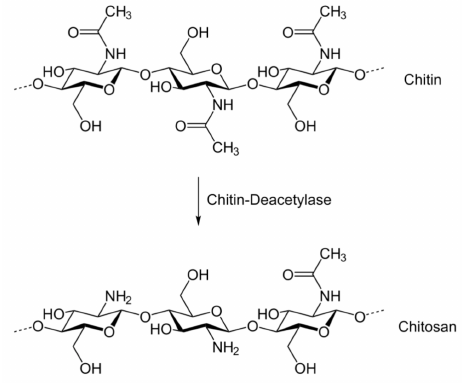
Figure 1. Chitosan structure [1].